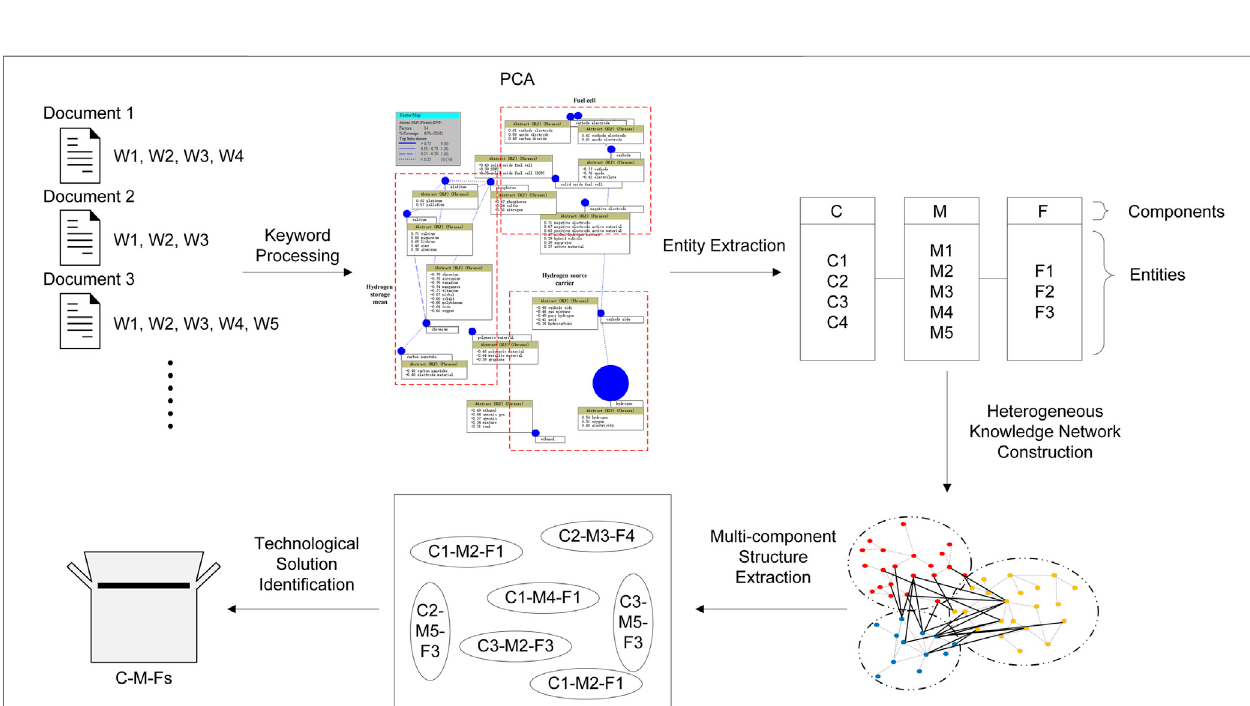
FIGURE 4 | Identifying the technological solutions in scienti fi c